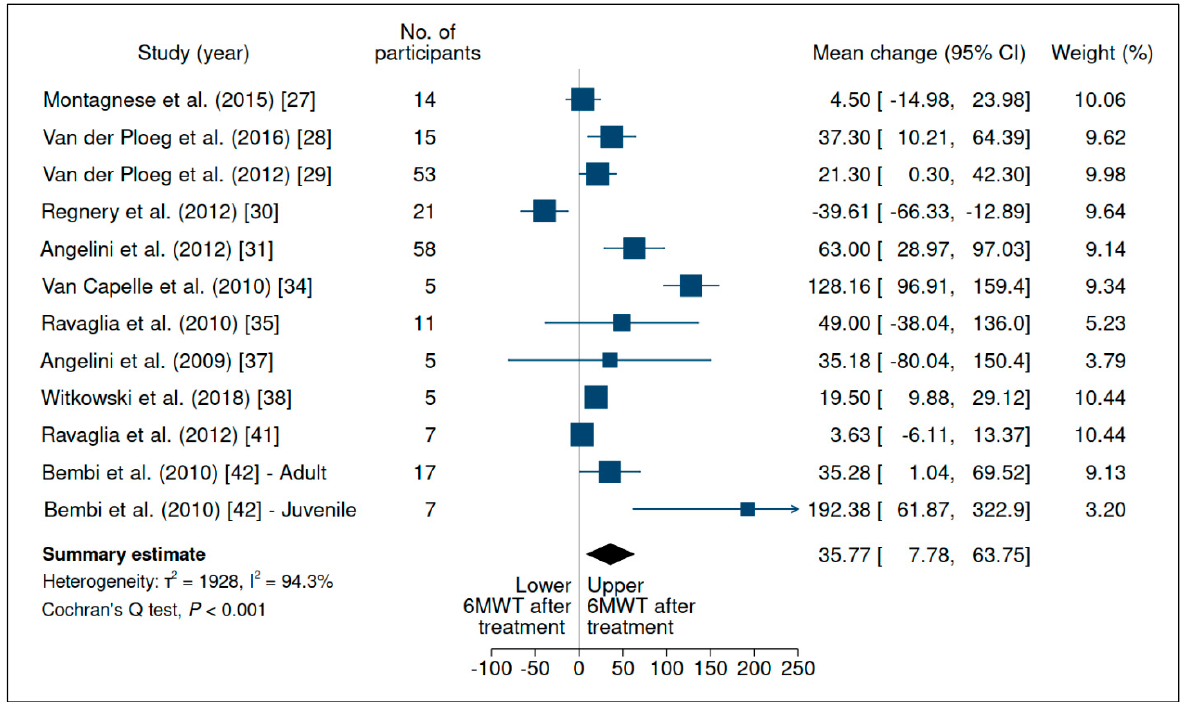
Figure 3. Evaluation of 6-min walking test performance (distance walked in meters) in patients with late-onset Pompe disease on enzyme replacement therapy with alglucosidase alfa. Weights are inverse-variance weights and are proportional to the contribution of each study to the summary estimate. I² is the fraction of variance that is due to statistical heterogeneity and not chance. Tau² denotes the between-study variance